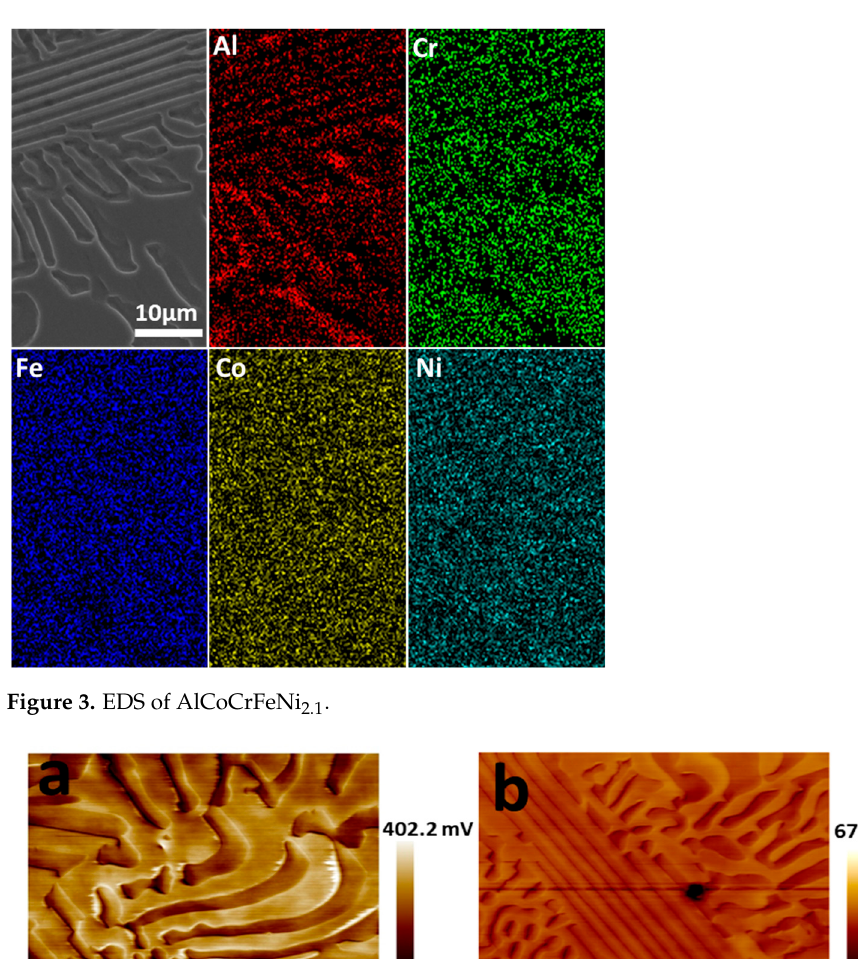
Figure 2. EBSD results of AlCoCrFeNi 2.1 : ( a ) IPF map; ( b ) Grain map; ( c ) Phase map; ( d ) KAM map.